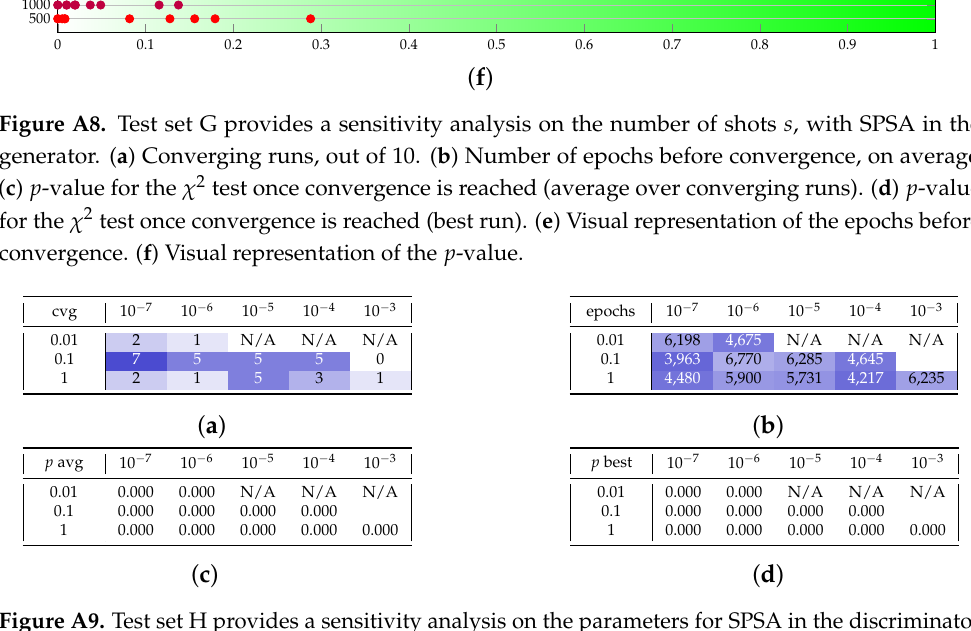
(f) Visual representation of the p -value. Figure A8. The test set G provides a sensitivity analysis on the number of shots s , with SPSA in the generator. (e) Visual representation of the epochs before convergence.